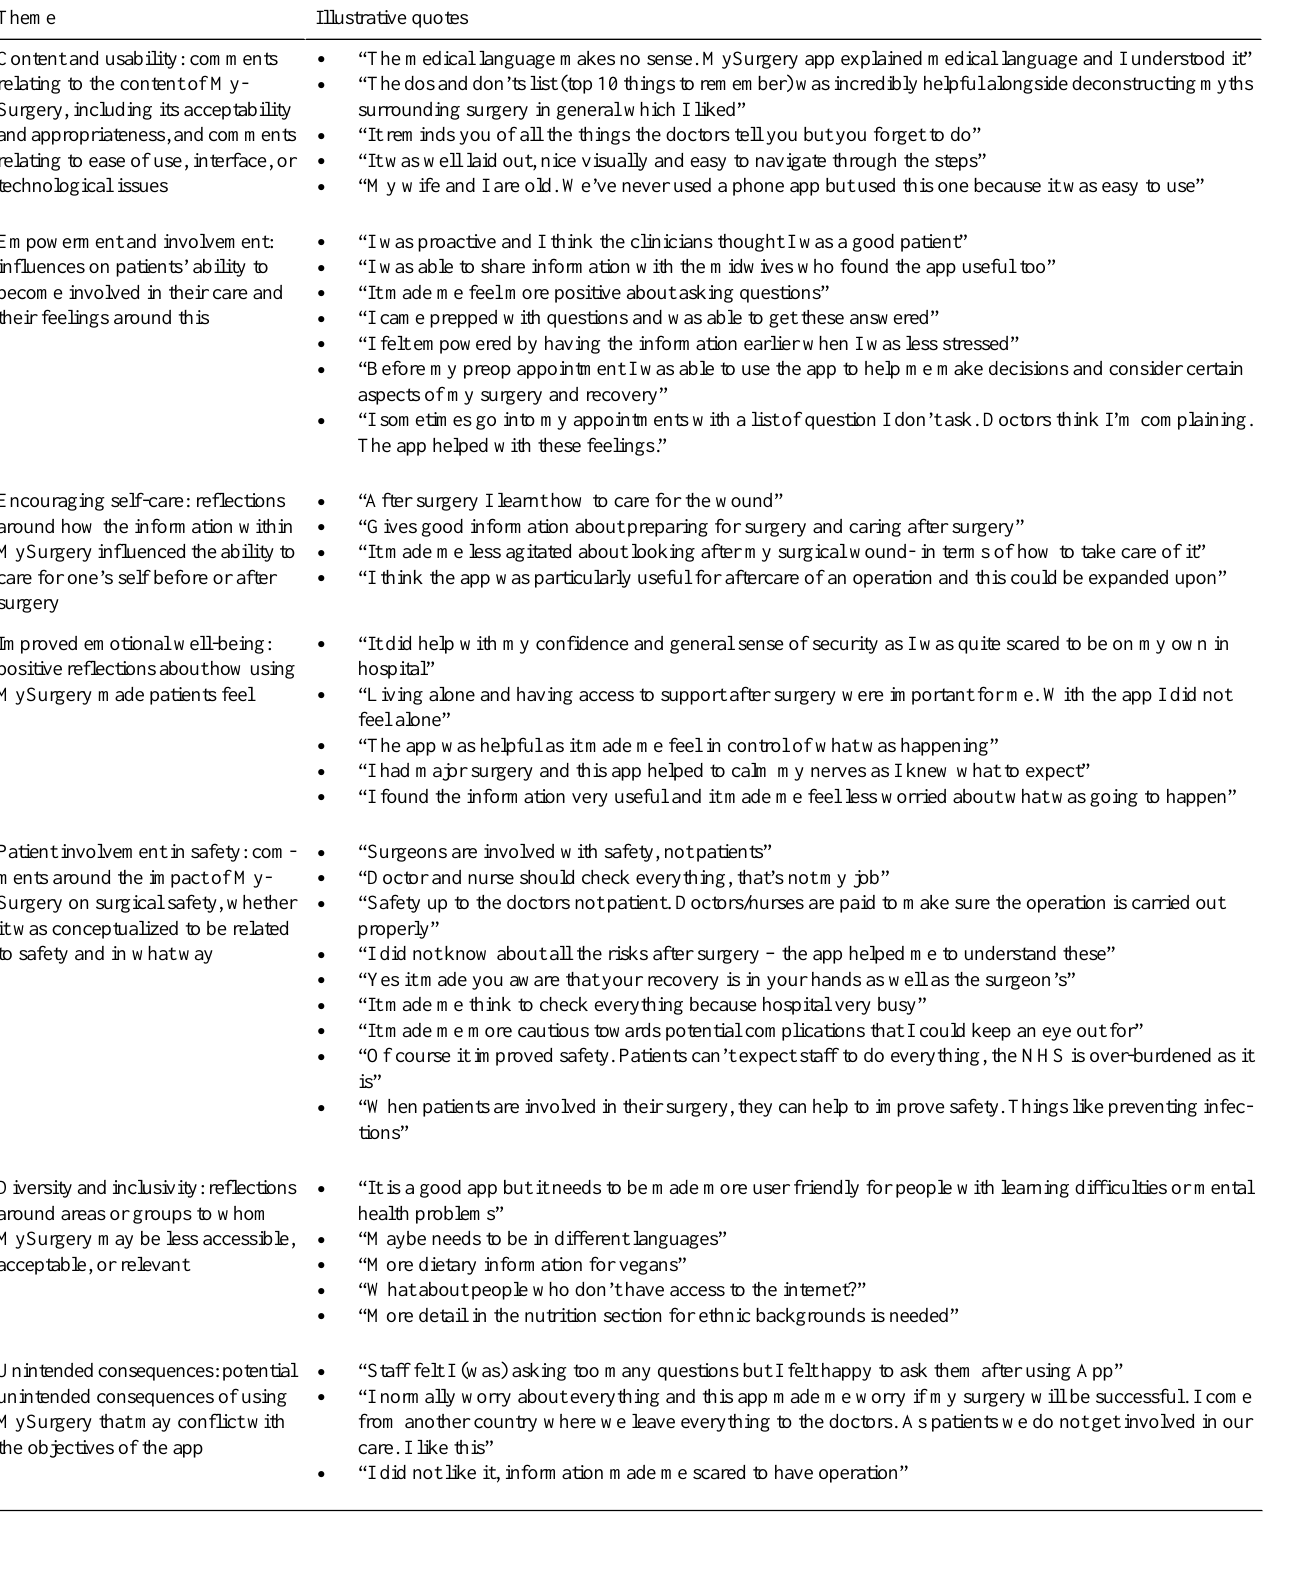
Table 3. Themes extracted from reflective notes with illustrative quotes